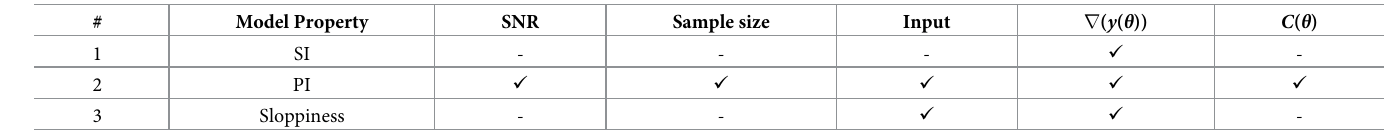
Table 2. Factors influencing model